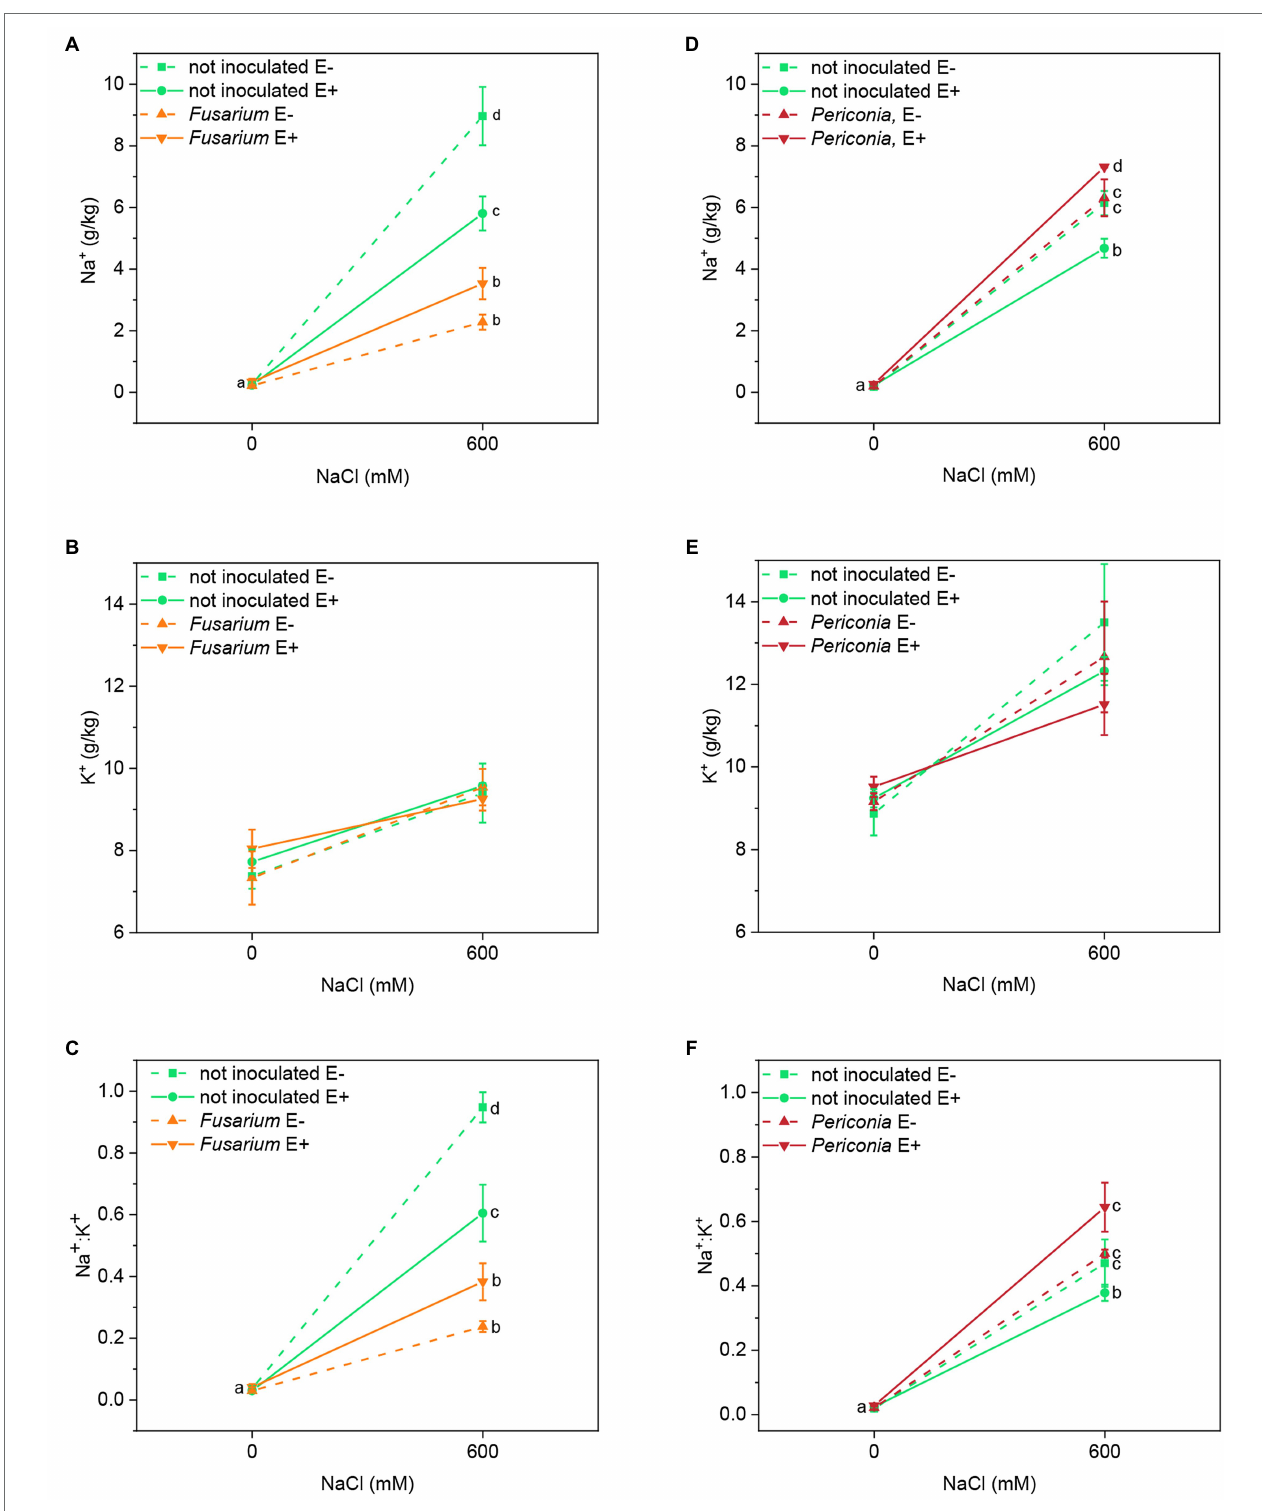
FIGURE 3 | Leaf sodium and potassium content and Na + :K + ratio in two FRP lines, EB15 (A–C) and TH12 (D–F) . Each line was composed by clones symbiotic with E. festucae (E + ) or Epichloë free (E – ). Plants of each line were inoculated with F. oxysporum T48 (orange), P. macrospinosa T131 (dark red), or uninoculated (green), and subjected to two different salinity treatments (0 and 600 mM NaCl). Where a significant [salinity × Epichloë × root endophyte] interaction occurred, different means are indicated by different